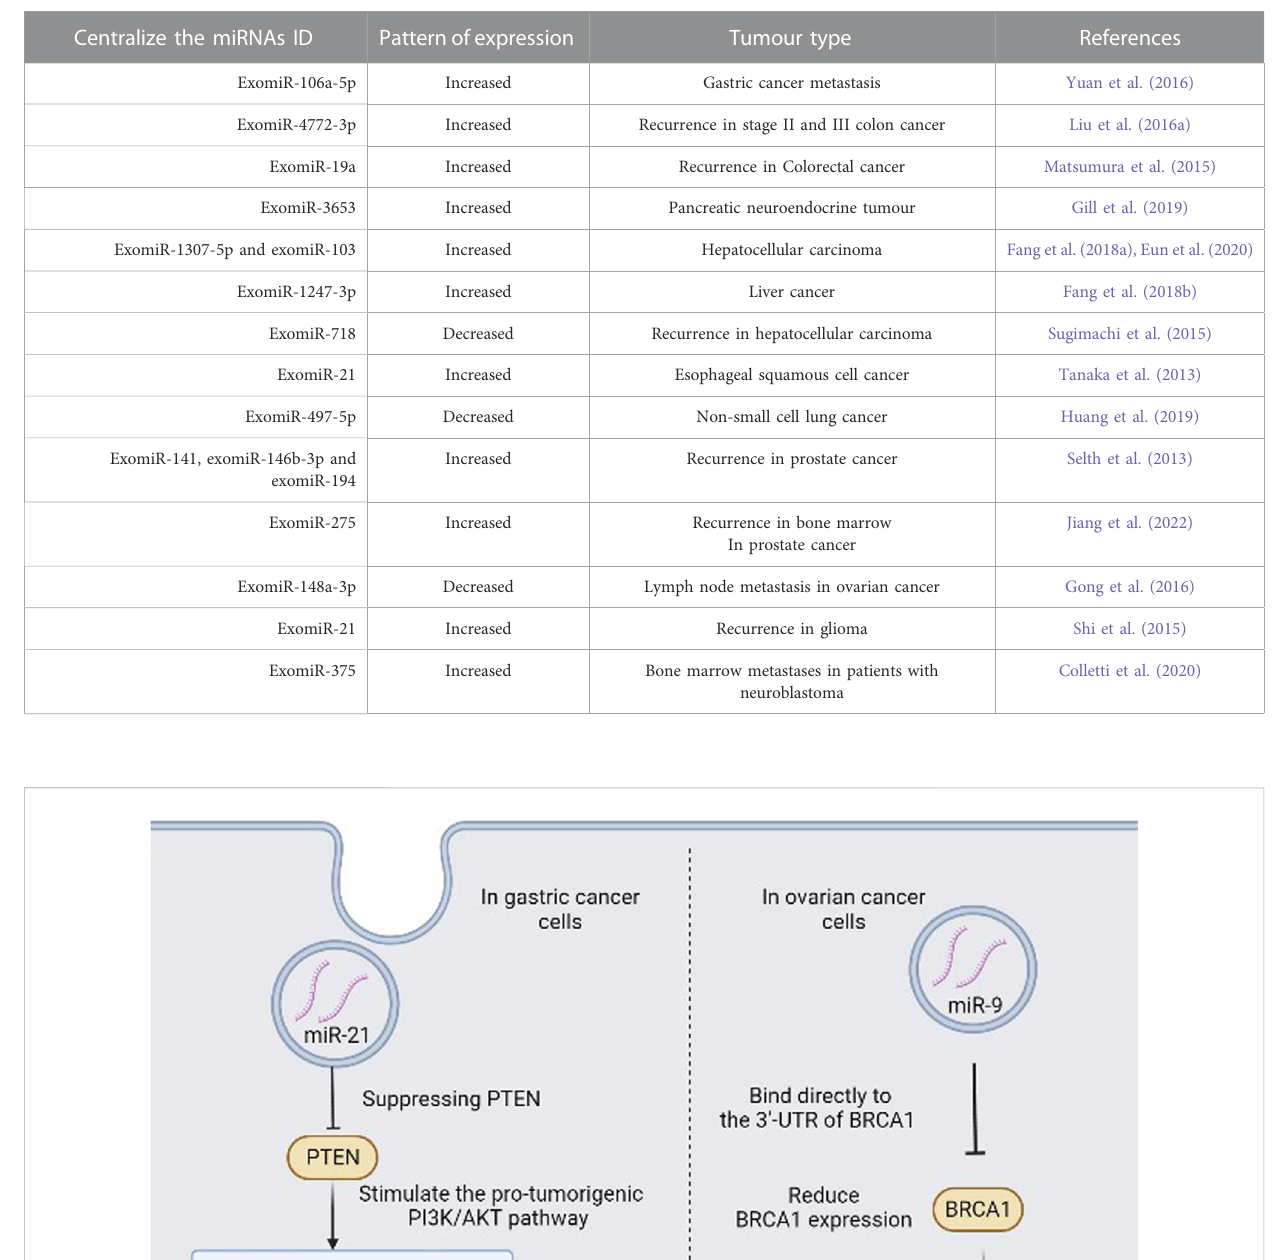
TABLE 3 List of exomiRs associated with tumour recurrence.